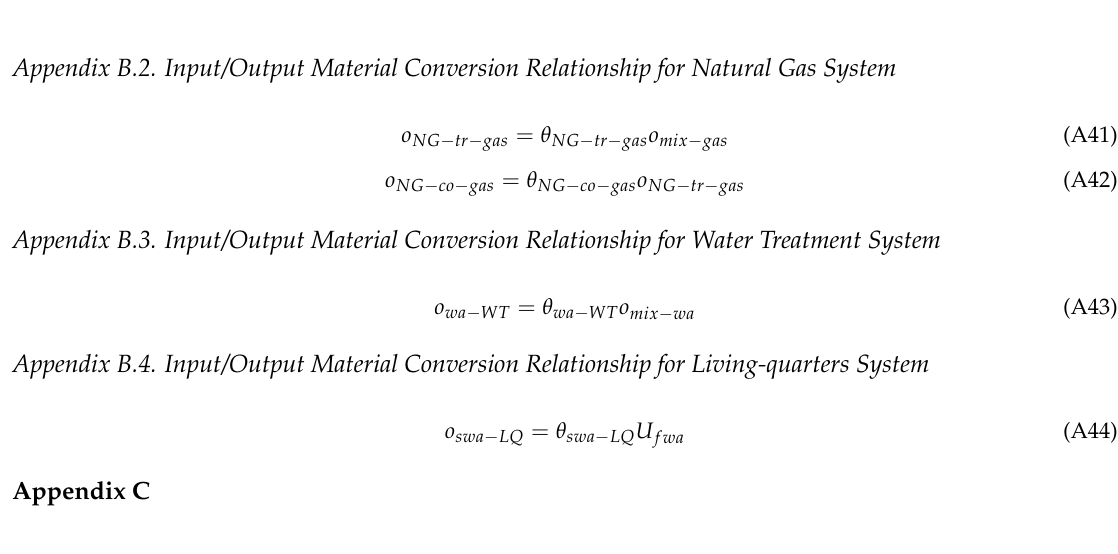
Table A1. The characteristics of 26 MW to 35 MW gas turbine.